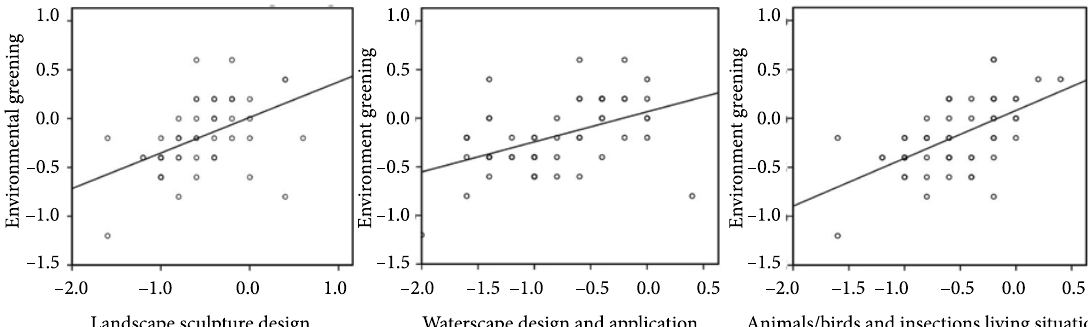
Fig. 6. Regression scatter diagrams between environmental greening and other